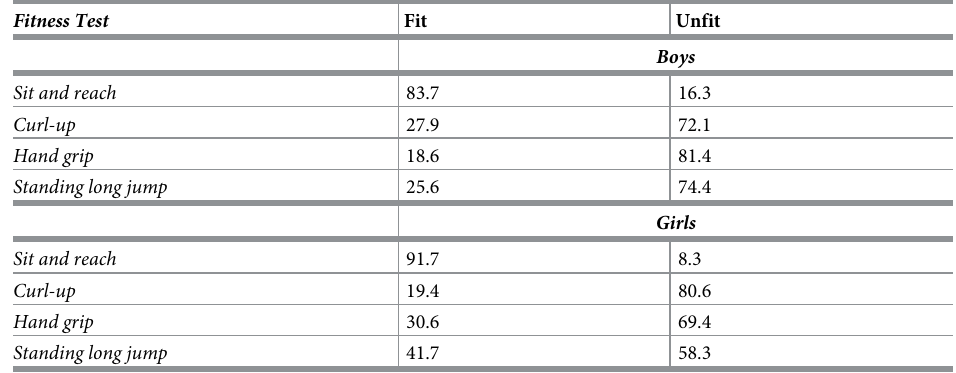
Table 3. Proportion (%) of subjects by fitness category (fit and unfit).